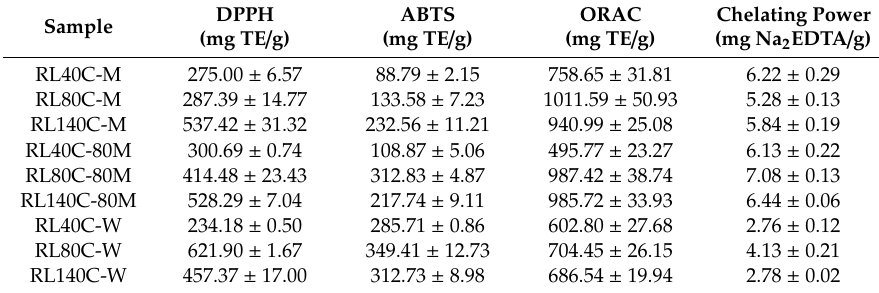
Table 3. Antioxidant activity of Rhododendron luteum Sweet extracts. The results of 2,2-diphenyl-1-picrylhydrazyl radical scavenging assay (DPPH), antiradical capacity determination with 2,2 (cid:48) -azino-bis-3(ethylbenzthiazoline-6-sulphonic acid) (ABTS) and Oxygen Radical Absorbance Capacity (ORAC) assay are expressed as mg TE (Trolox equivalents) / g of dry extract. The results of